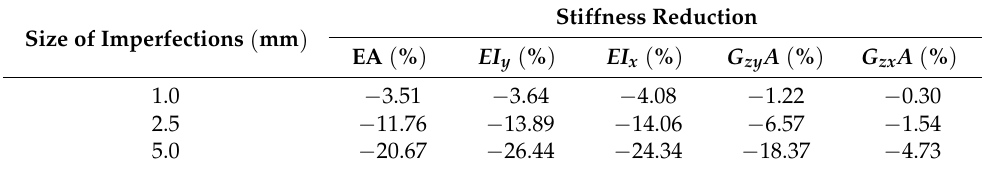
Table 4. Stiffness reduction of Z profile with an elongation of 100 mm due to bending about the horizontal axis for case (ii), i.e., the tension of the lower part of the cross-section, depending on the size of